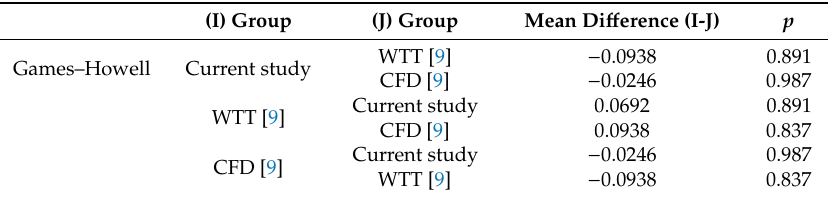
Table 3. ANOVA test results.